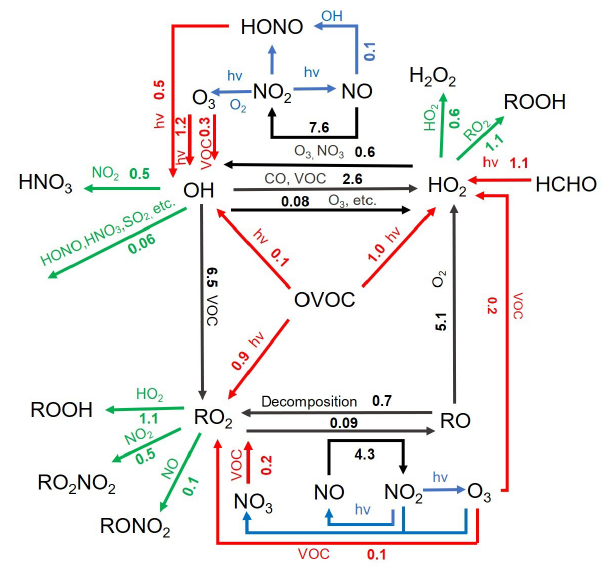
Figure 12. Daytime (06:00–18:00LT) average RO x budget during the summertime O 3 episode days. The unit is parts per billion per hour. The red, green, and black lines indicate the production, de- struction and recycling pathways of radicals,